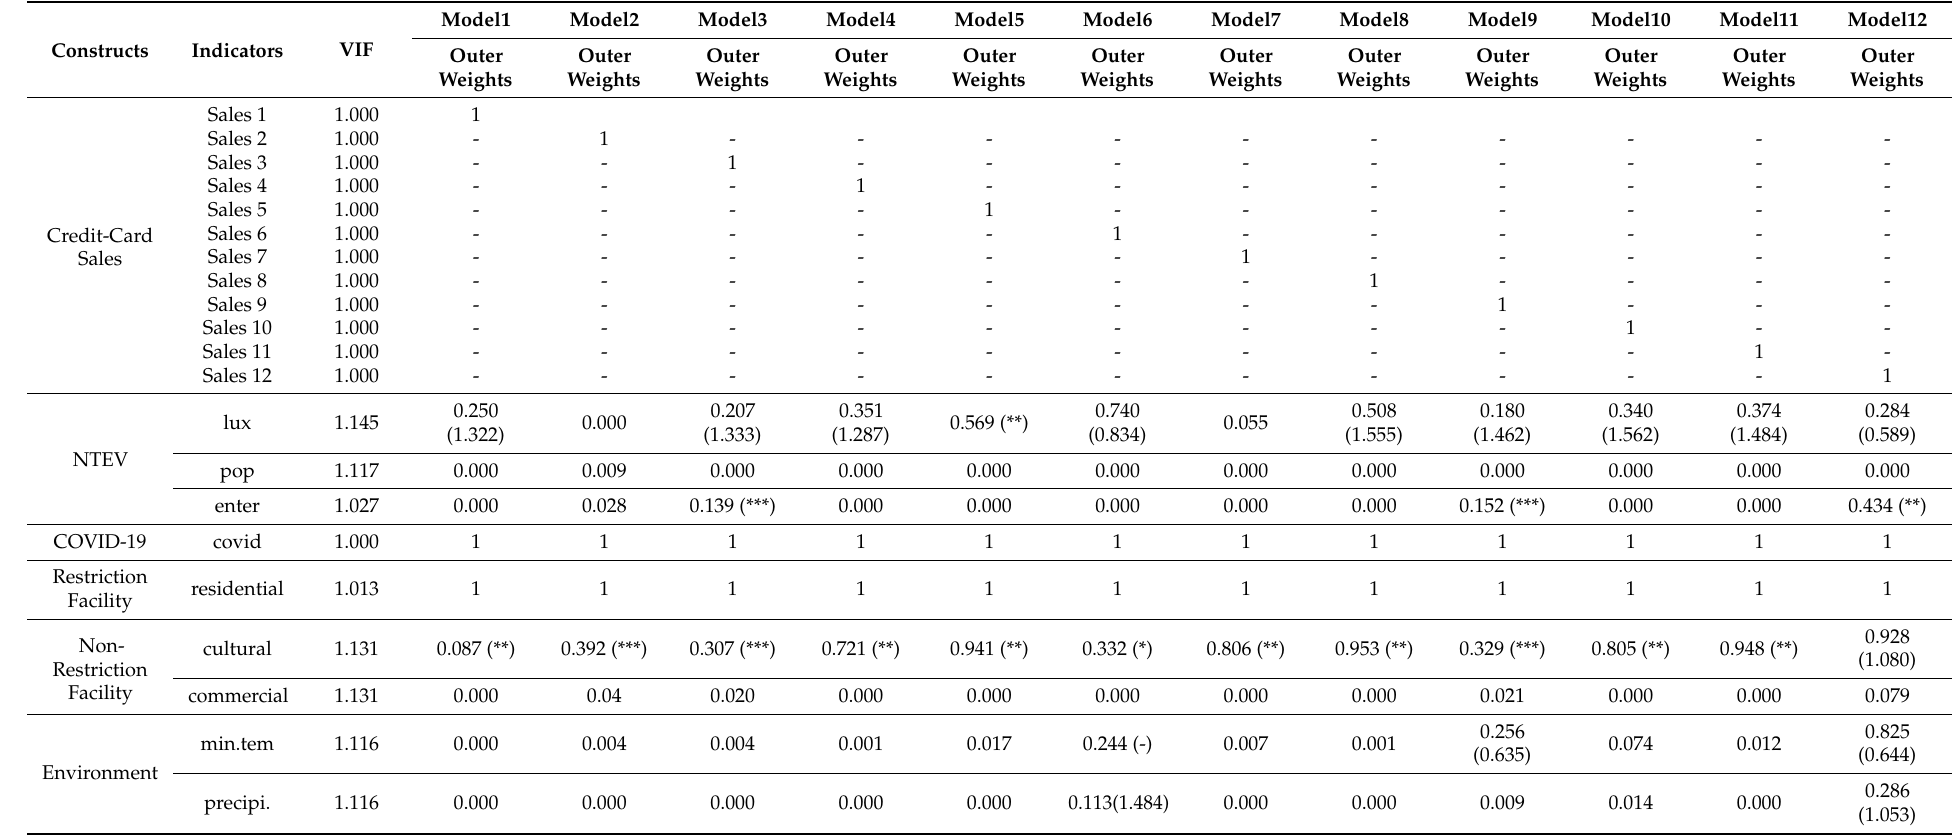
Table 6. Indicator validity